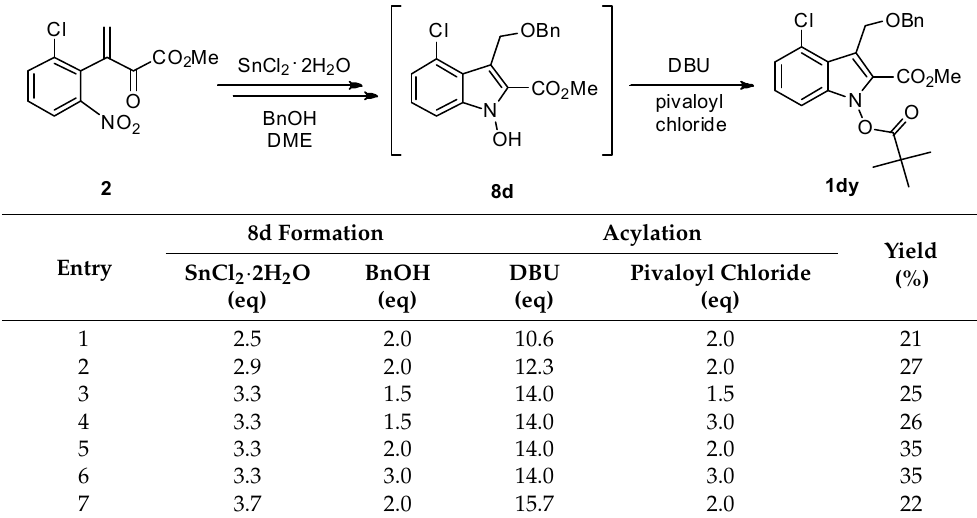
Table 1. Optimization of the reaction conditions for 1dy a .